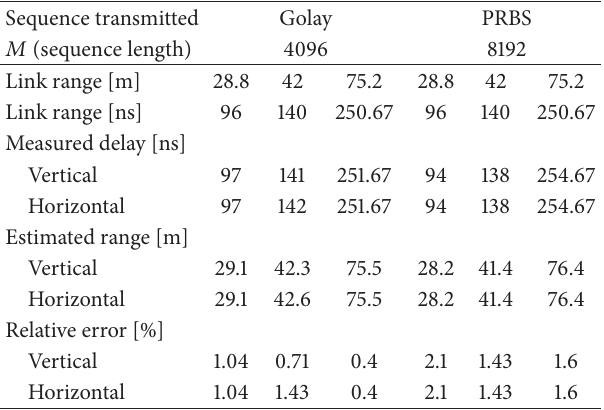
Table 5: Range estimation results—single target case.